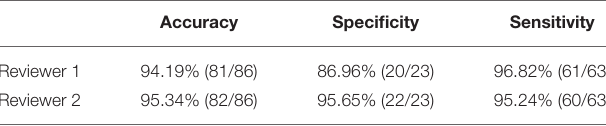
TABLE 5 | Diagnostic performance of SPECT/CT in 86 extremity